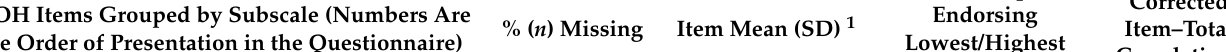
MOH Items Grouped by Subscale (Numbers